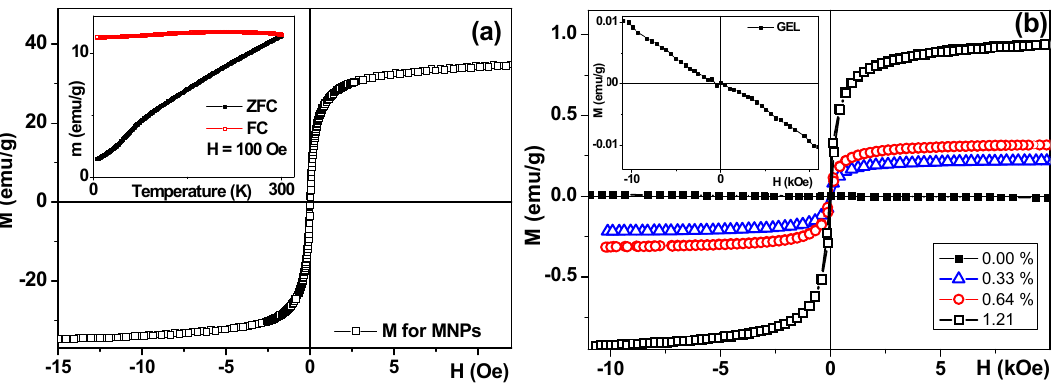
Figure 3. Magnetic hysteresis loop of air-dry nanoparticles measured at room temperature; inset shows thermomagnetic zero field cool–field cool curve (ZFC-FC) curve ( a ). Hysteresis loops for FG1-0, FG1-1, FG1-2, and FG1-3 samples measured at room temperature ( b ); inset shows diamagnetic response of the blank gel.